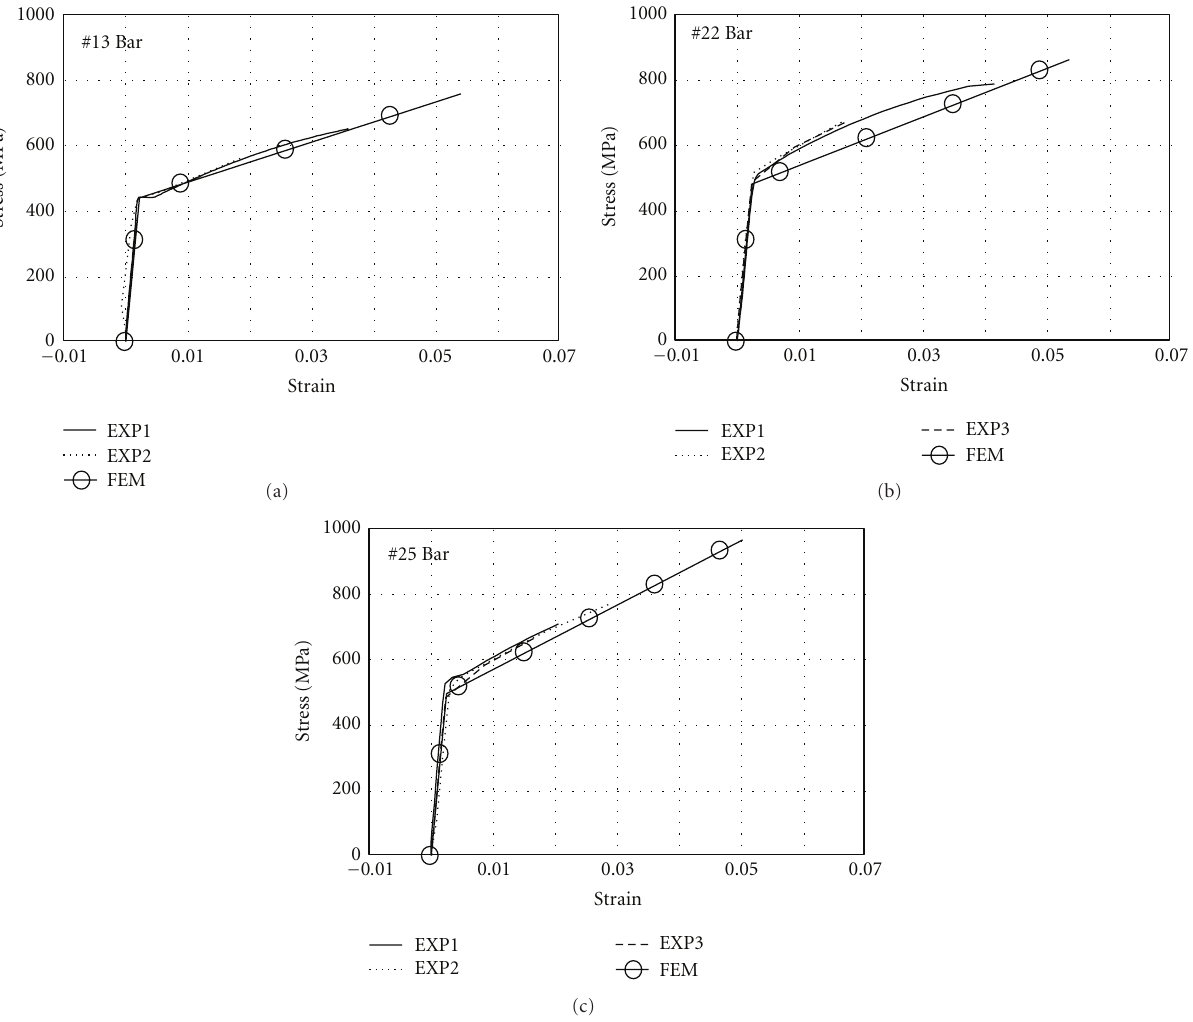
Figure 6: Stress-strain relationship for steel reinforcing bar modeling.